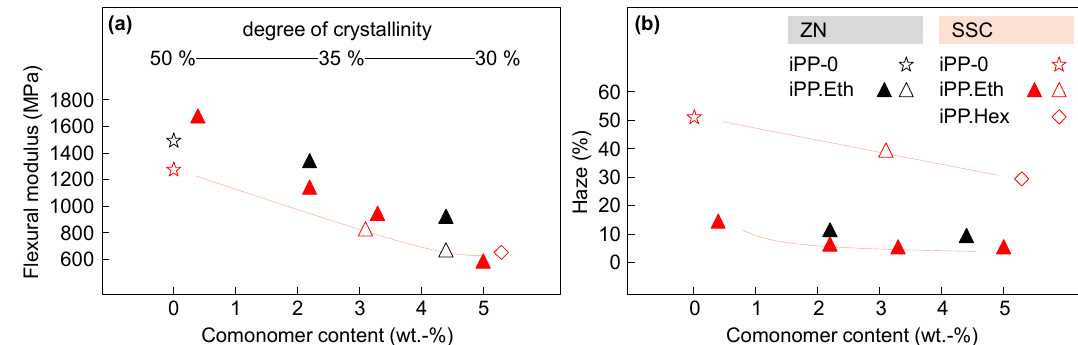
Figure 7. Flexural modulus of elasticity ( a ) and haze ( b ) as a function of comonomer content of propylene random copolymers based on SSC or ZN catalysts. Filled symbols stand for nucleated samples and non-filled symbols for non-nucleated samples.